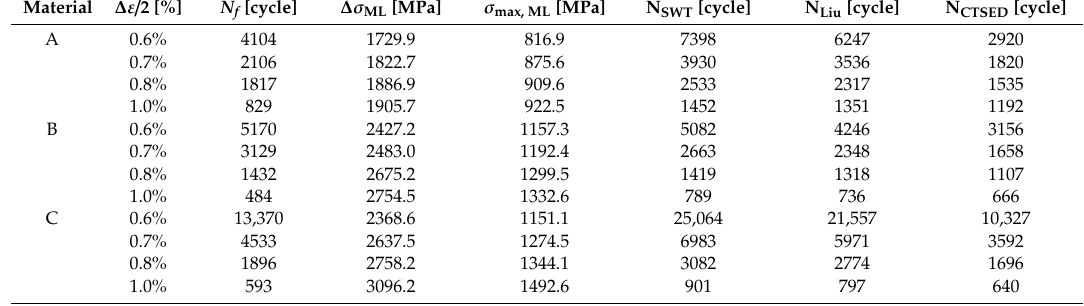
Table 5. Fatigue life predictions and experimental fatigue lives.